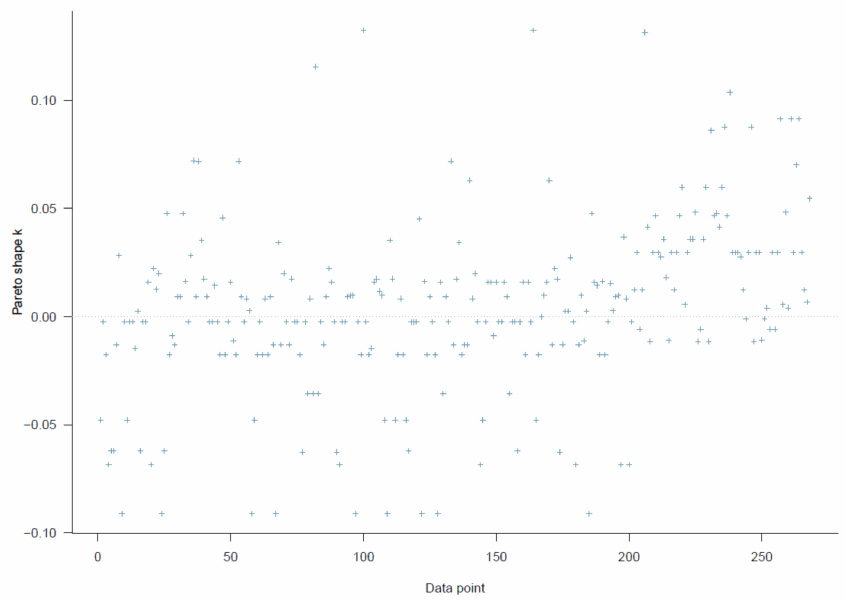
Figure 3. Model 1 (cid:48) s Pareto smoothed importance-sampling (PSIS) diagnostic